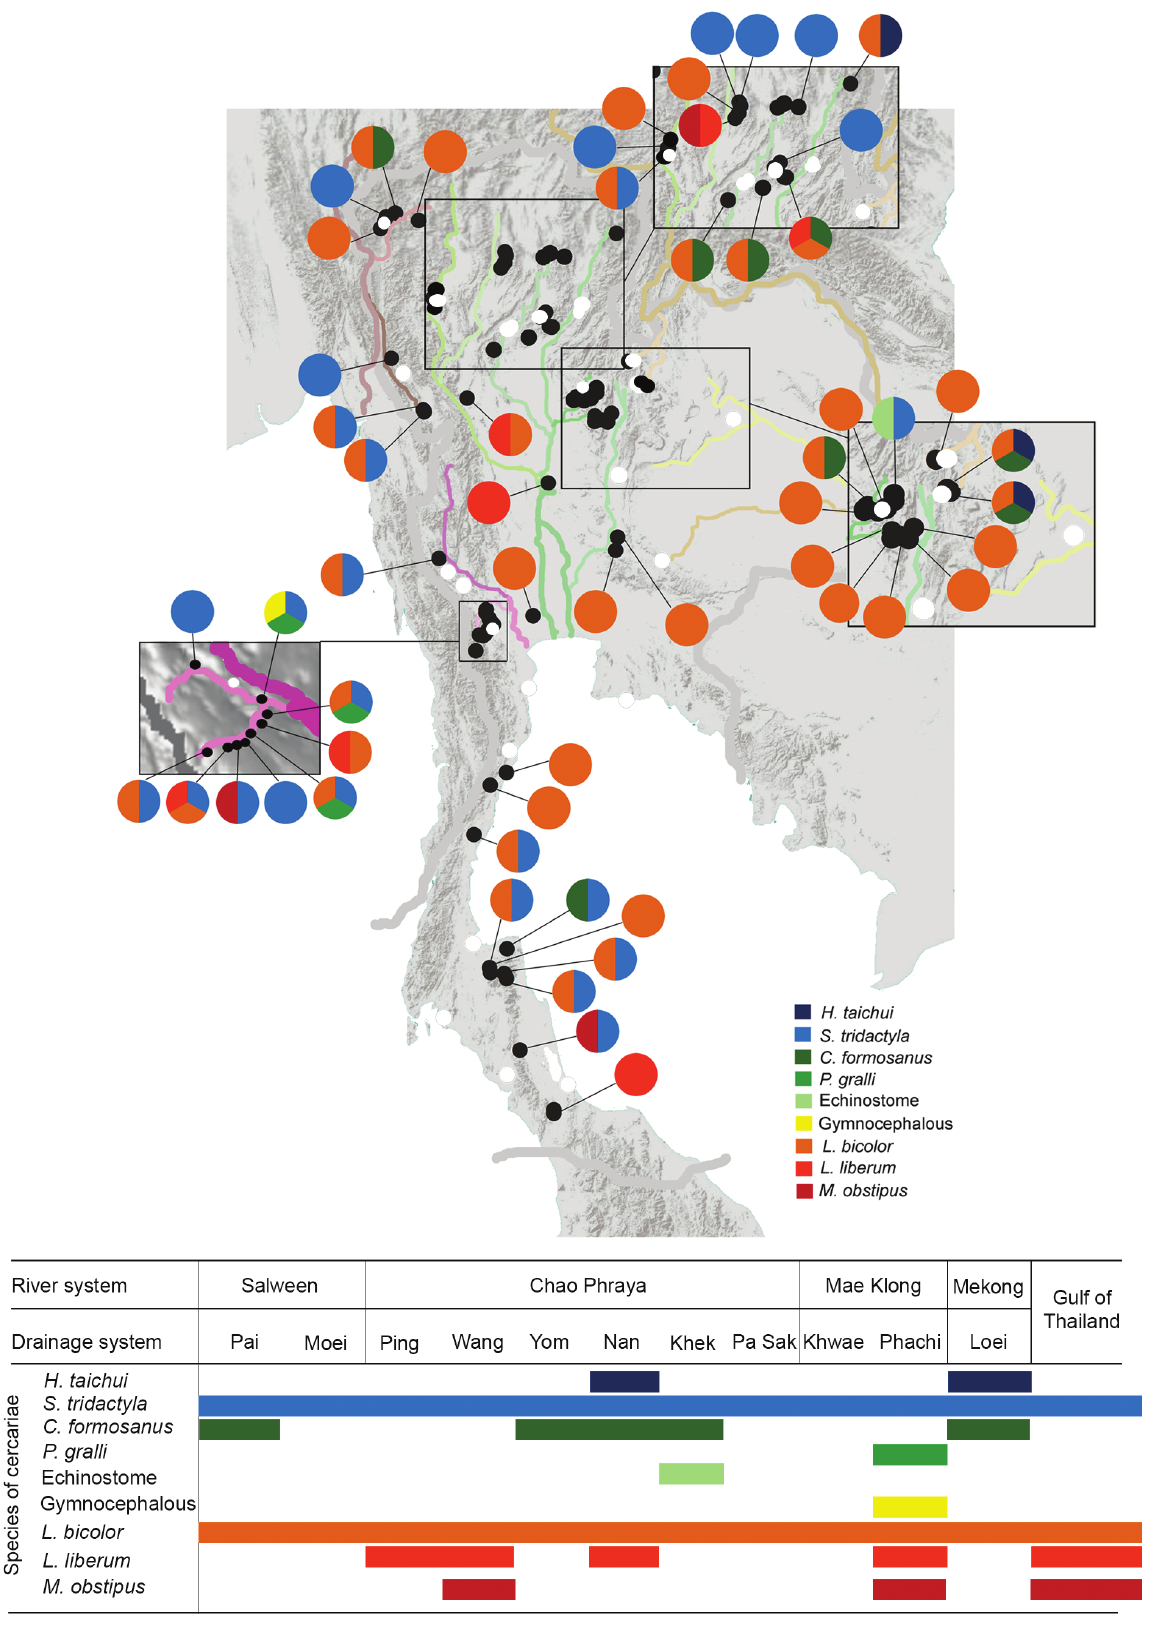
Figure 2. Distribution of Tarebia granifera and trematodes in different river systems in Thailand. a . Distribution map. b . Comparative table of the occurrence of trematode cercariae in different river systems in Thailand. Black dots with attached pie charts in the map represent sampling sites where trematode infected specimens of T. granifera were found; white dots represent sampling sites where no infections were observed. Colors in the pie charts and the comparative table refer to trematode species/types (see legend